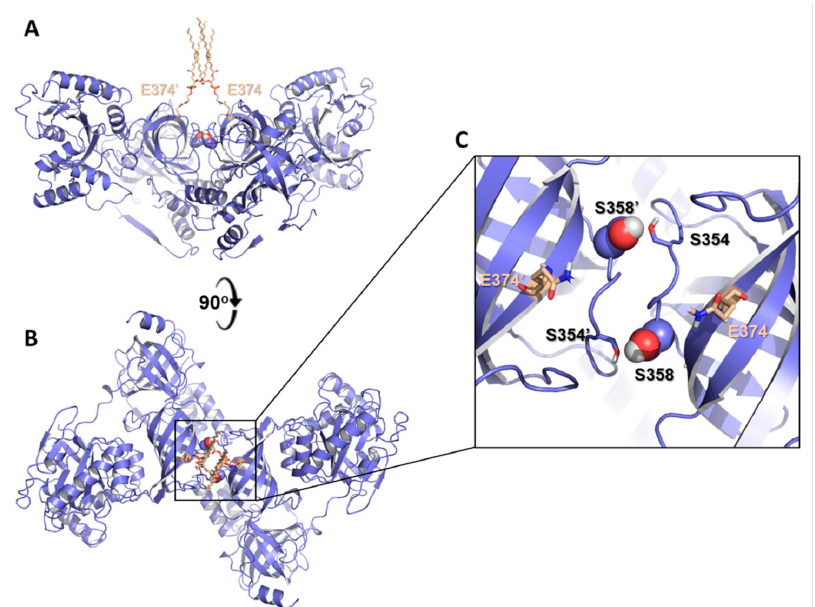
Figure 4. Side-by-side arrangement of two eEF1A2 monomers, each displaying a PE molecule covalently bonded to Glu374 (cream color), as found in the crystal lattice of the eEF1A2 structure solved by X-ray diffraction [58,59]. Views in ( A ) (equivalent to the upper part of Figure 3B) and ( B ) are related by a 90 ◦ rotation about the X-axis. The view enlarged in ( C ) shows the location of Ser354 (side chains as sticks) and Ser358 (side chains as spheres) in both